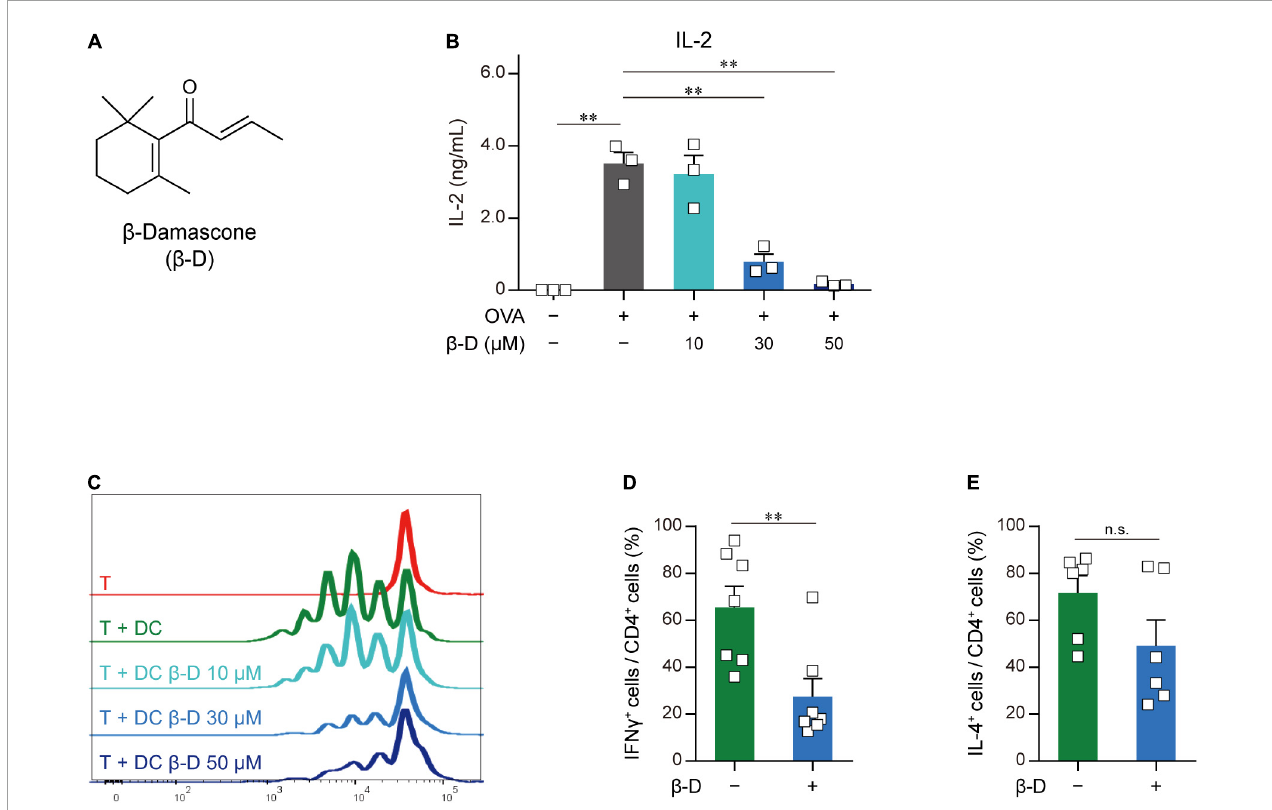
FIGURE1 Effects of β -damascone on the DC-mediated activation of T cells. (A) Structure of β -damascone. (B) IL-2 concentrations in the culture media of OT-II splenocytes. A total of 1.0 × 10 5 cells obtained from the whole spleen of OT-II mice were maintained in the presence or absence of 500 ng of the OVA peptide and the indicated concentration of β -damascone ( β -D) in 200 µ l pf culture media for 72 h. (C) Division of OT-II CD4 + T cells cocultured with OVA-pulsed BMDCs. CFSE-labeled OT-II CD4 + T cells (5.0 × 10 4 ) were cocultured with or without C57BL/6 BMDCs (1.0 × 10 4 ), which were pretreated with 500 ng of the OVA peptide, in the presence or absence of the indicated concentrations of β -damascone in 200 µ l of culture media for 72 h. (D,E) Effects of β -damascone on the frequencies of Th1 and Th2 cells that developed under polarizing conditions in a DC-dependent manner. OT-II naïve CD4 + T cells were cocultured with OVA-pulsed C57BL/6 BMDCs under Th1- or Th2-polarizing conditions in the presence or absence of β -damascone (30 µ M) for 72 h. The percentages of (IFN- γ + /CD4 + T cells) / (total CD4 + T cells) (D) and (IL-4 + /CD4 + T cells) / (total CD4 + T cells) (E) were shown, and a gating strategy of the flow cytometric analysis of CD4 + T cells and the actual number of cells are shown in Supplementary Figure 2 . The Tukey-Kramer test was used (B–E) . ∗∗ p < 0.01, n.s.: not significant.